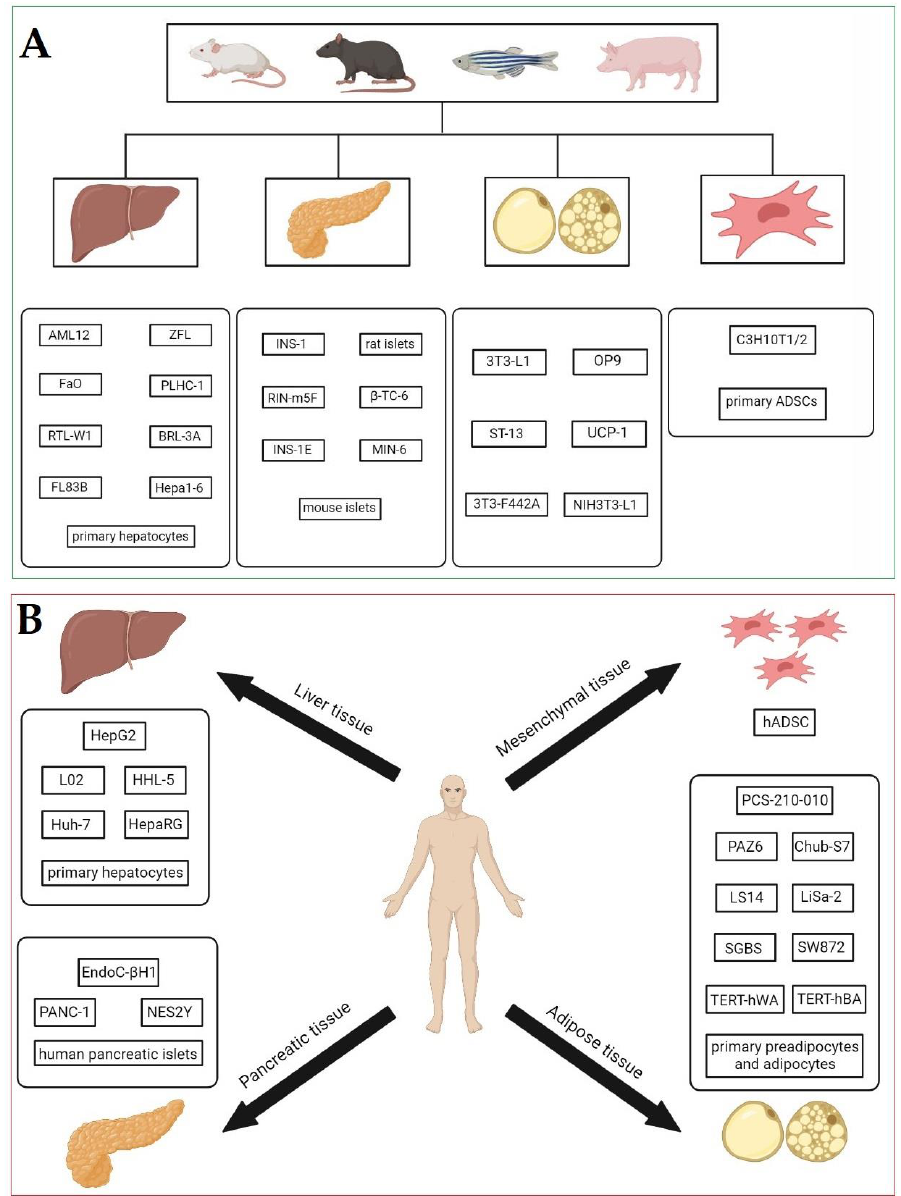
Figure 2. In vitro models applied in the study of the obesogenic action of endocrine-disrupting chemicals (EDCs): ( A ) animals, and ( B ) humans. chemicals (EDCs): ( A ) animals, and ( B )